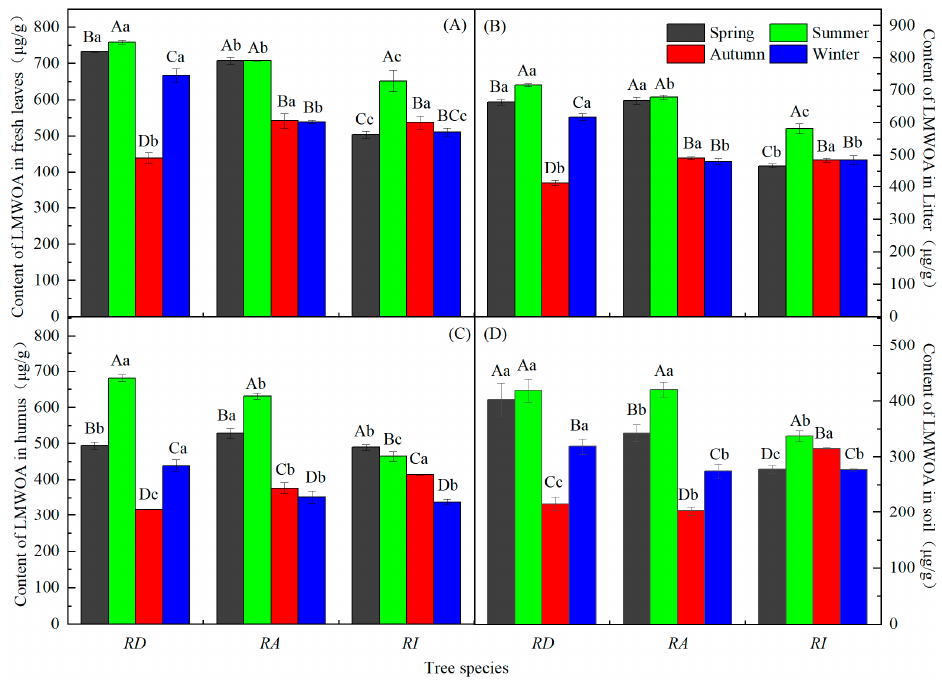
Figure 3. Seasonal dynamics of the LMWOAs in the different rhododendron forests. Note: ( A – D ) in the figure represent the seasonal dynamics of the LMWOAs in the fresh leaves, litters, humus, and soils in three rhododendron forests; different capital letters indicate the same azalea forest, and the LMWOAs’ content during the different seasons reached a significant level ( p < 0.05); different lowercase letters indicate different azalea forests, and the LMWOAs’ content reached a significant level during the same season ( p < 0.05). The values are the mean ± SE.